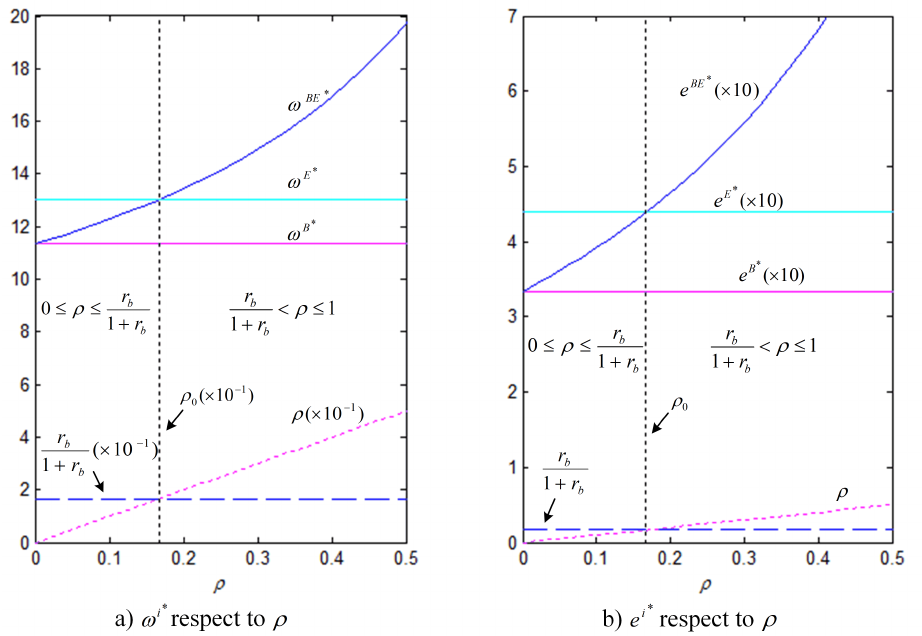
∗ ∗ ∗ ∗ , q i , π i m , π i r with respect to θ ( r b = 0.1, ρ = 0.3, η = 0.5, i = B , E , BE ).